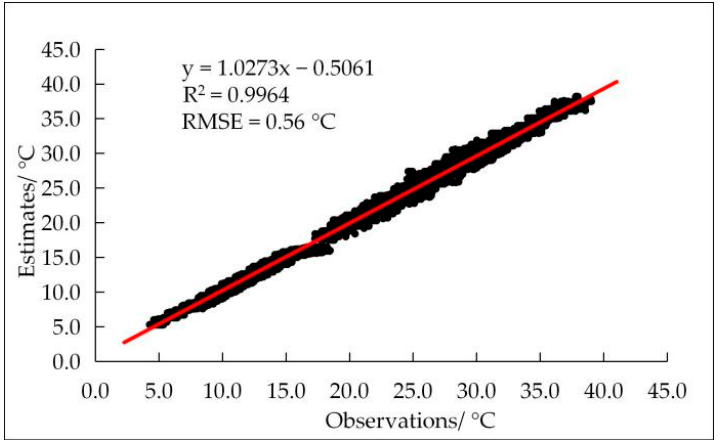
Figure 5. Linear fitting analysis chart of estimated and observed values. The observed data are the temperature data of M2 and M3. The red curve is the linear fitting curve, and the black dots are the observed and estimated values.